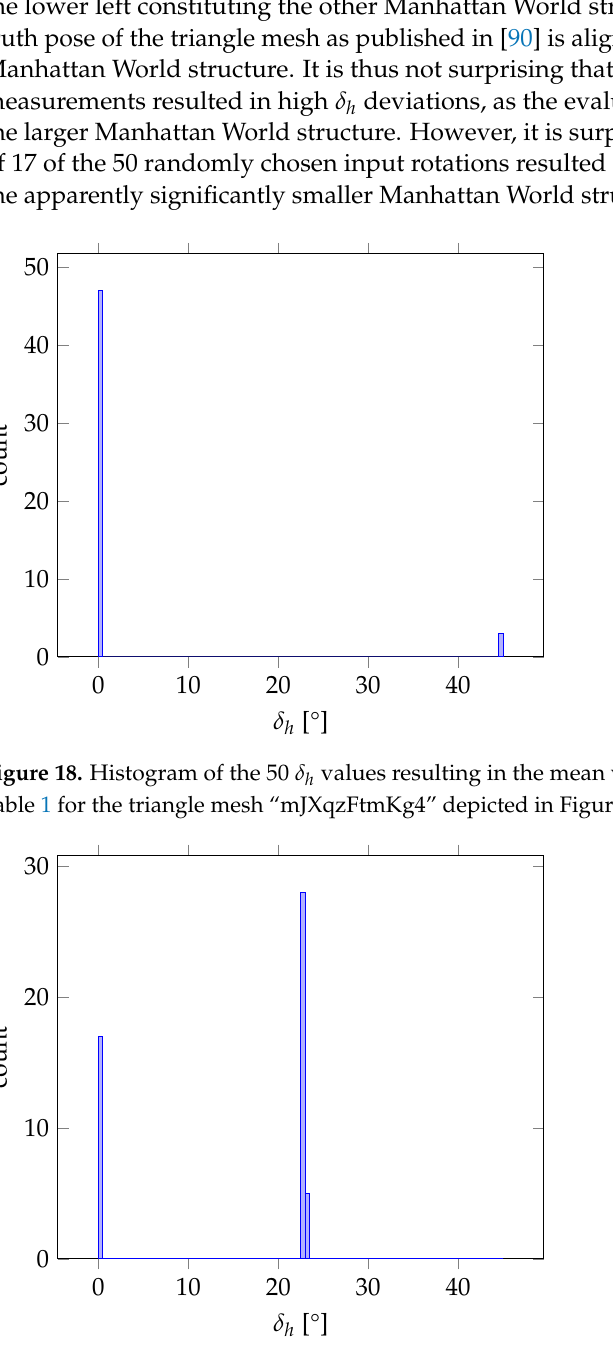
Figure 19. Histogram of the 50 δ h values resulting in the mean value of 15.28° ± 20.07° presented in Table 1 for the triangle mesh “PuKPg4mmafe” depicted in Figure